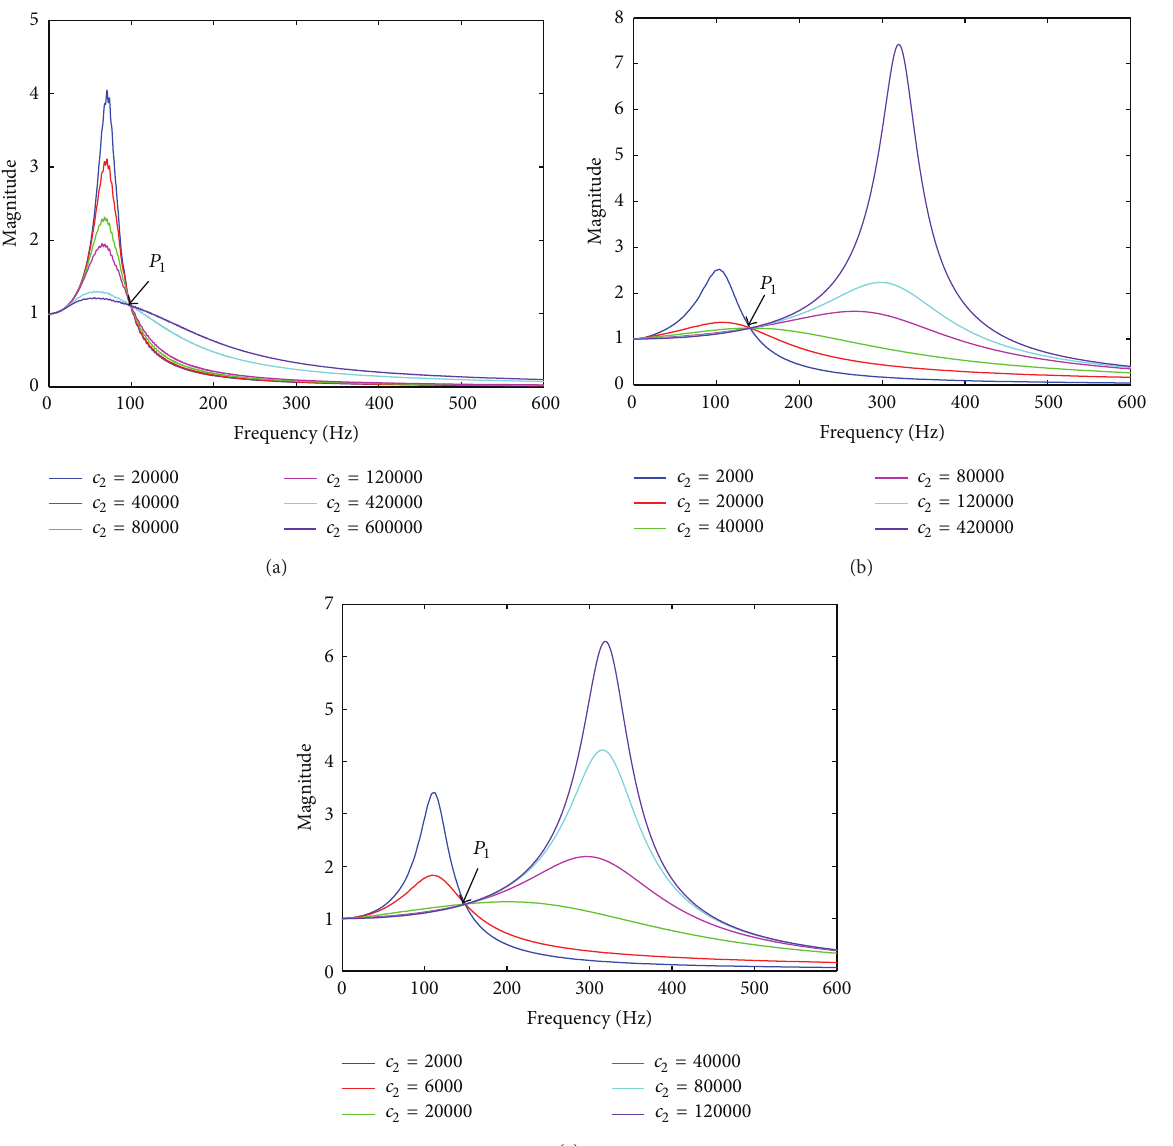
Figure 23: Force transmissibility curves of CM under 50N FE cases. (a) 𝑛 1 = 1.5 ; (b) 𝑛 1 = 1 ; (c) 𝑛 1 = 0.85 .